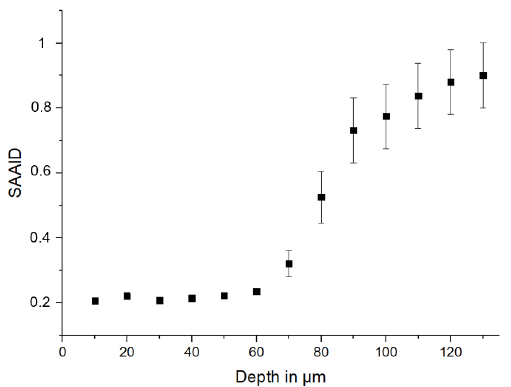
Figure 1. SHG-to-AF Aging Index of Dermis (SAAID). The SAAID was measured from the stratum corneum to a depth of 130 µm on the volar forearm and is steeply increasing in the papillary dermis in healthy skin of the volar forearm. The data show the mean ± standard deviation ( n = 24). These findings are reflected in the GLCM analysis up to 130 µ m shown in Figure